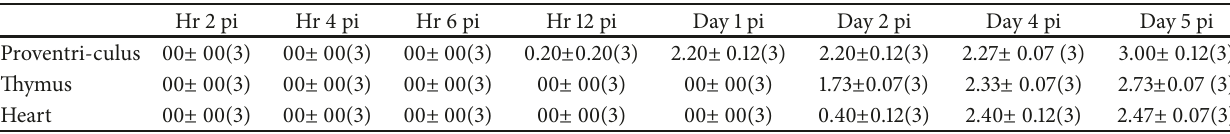
Table 7: Lesion scoring (0-4) induced by vNDV in HE stained tissues of proventriculus, thymus, and heart collected from hr 2 till day 5 pi. Hr 2 pi